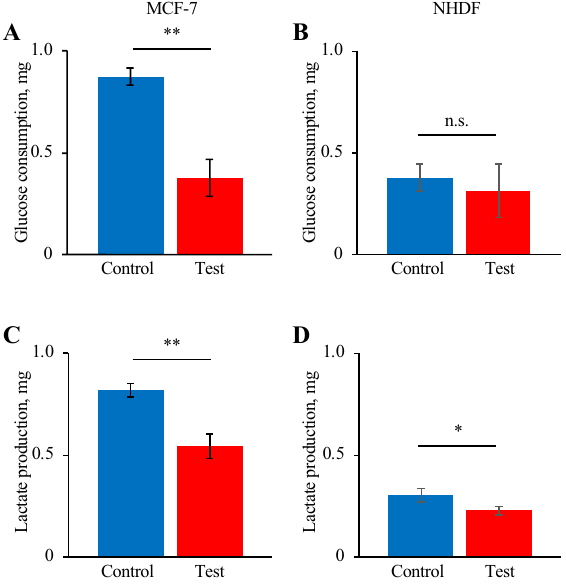
Figure 5. The indexes of glucose metabolism for 24 h of culture after thermal stimulus at 43 °C for 30 min. Glucose consumption of MCF-7 cells ( A ) and NHDFs ( B ) and lactate production of MCF-7 cells ( C ) and NHDFs ( D ) (n = 4, mean ±